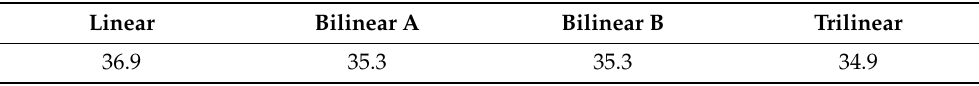
Figure 15. Compressive strength for different fracture energies. Multiplier applied only to G n , only to G s , and to both. Table 6. Compressive strength (MPa) for different post-peak curve shapes.